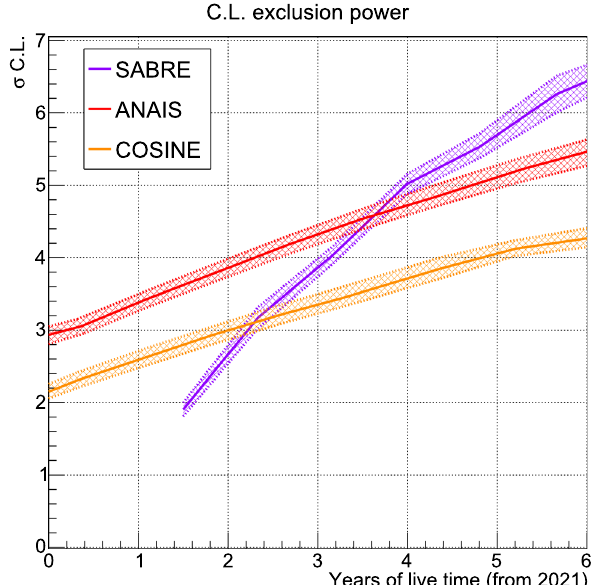
Fig. 7 Conservative exclusion power of NaI detectors, as a function of live time. Cross hatched regions indicated 1 σ statistical uncertainty bands